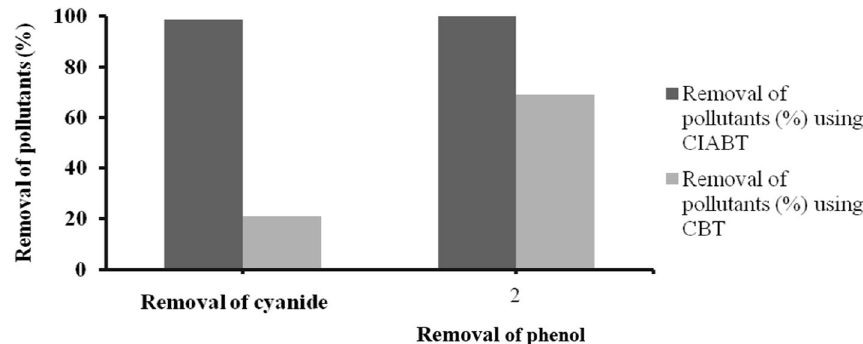
Fig. 6 Removal of pollutants using CIABT and